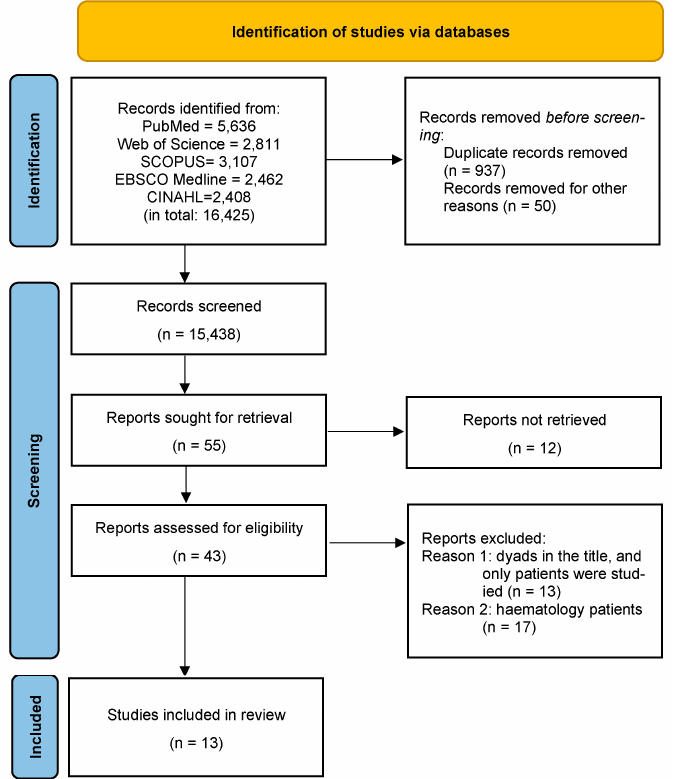
Figure 1. Preferred Reporting Items for Systematic Reviews Extension for Scoping Reviews Checklist (PRISMA-ScR) flow diagram. Note: In the screening phase, 15,383 records had a title/abstract not focused on a patient-informal caregiver dyad.